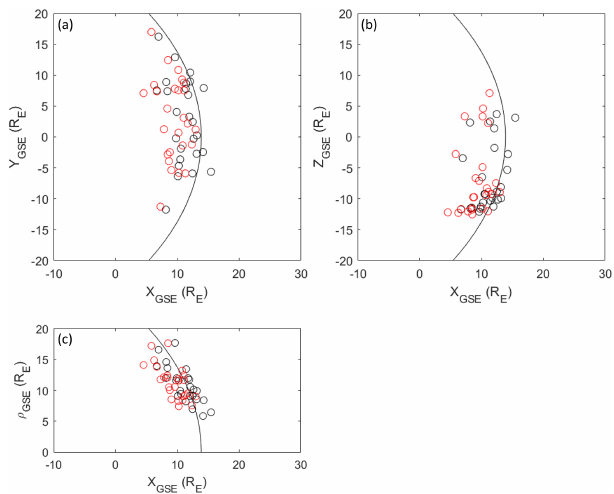
Figure 5. Positions of the magnetic holes in GSE x - y , x - z , and x - ρ (cid:113) + z 2 y 2 projections ( ρ GSE = ). Magnetic holes encountered GSE GSE in the solar wind are shown in black, while magnetosheath observa- tions are marked in red. Also shown is the bow shock position for average solar wind conditions (Kivelson et al.,